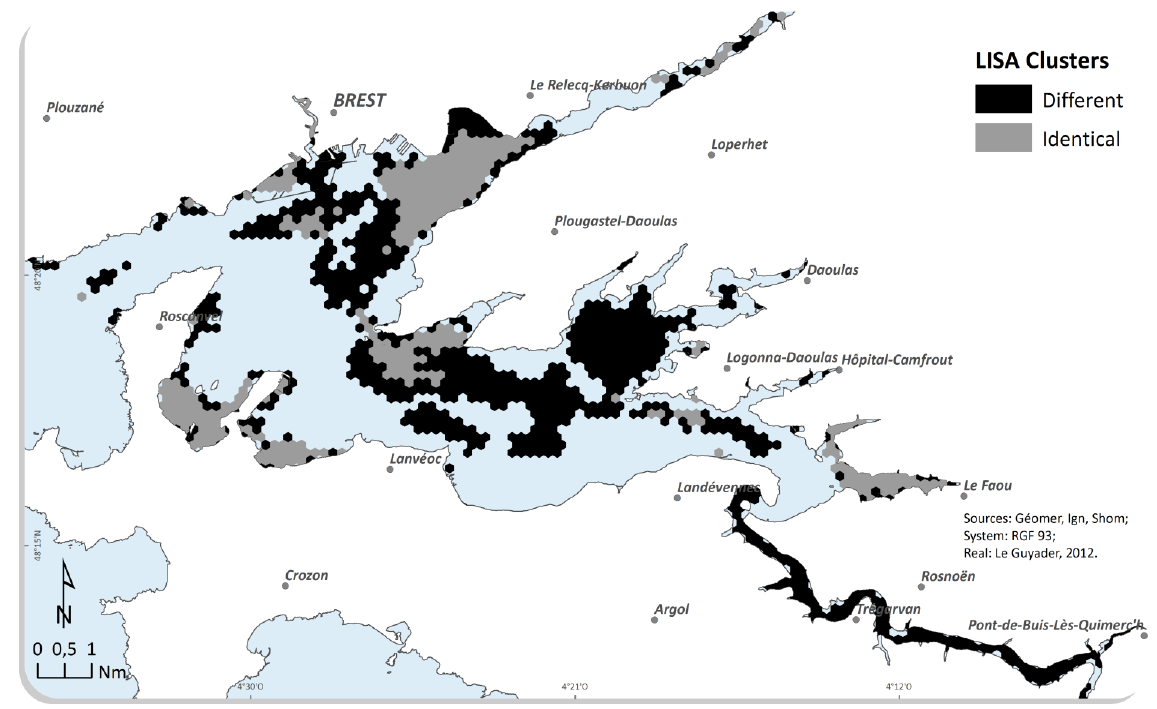
Figure 7. Comparison of significant clusters identified by the spatial intersections between activity zones to those identified by the spatio-temporal intersections between activity zones (2009, Bay of